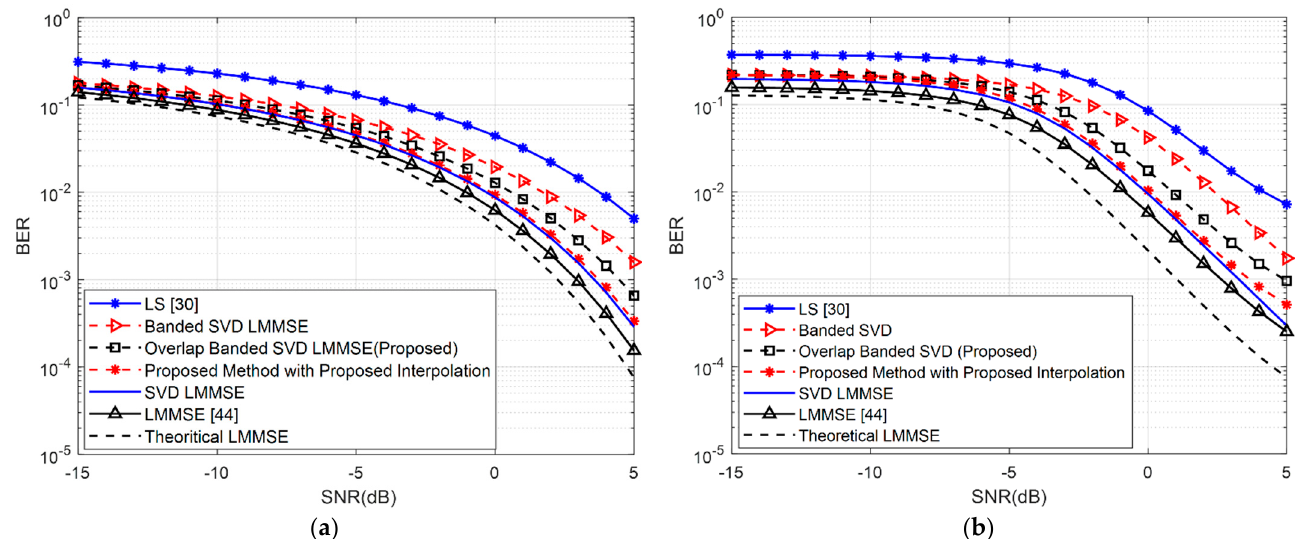
Figure 11. Bit error rate (BER) comparison of the proposed technique for conventional and proposed interpolation methods with traditional LMMSE and its other counterpart versions: ( a ) TU 1 Hz; ( b ) EPA 1 Hz.